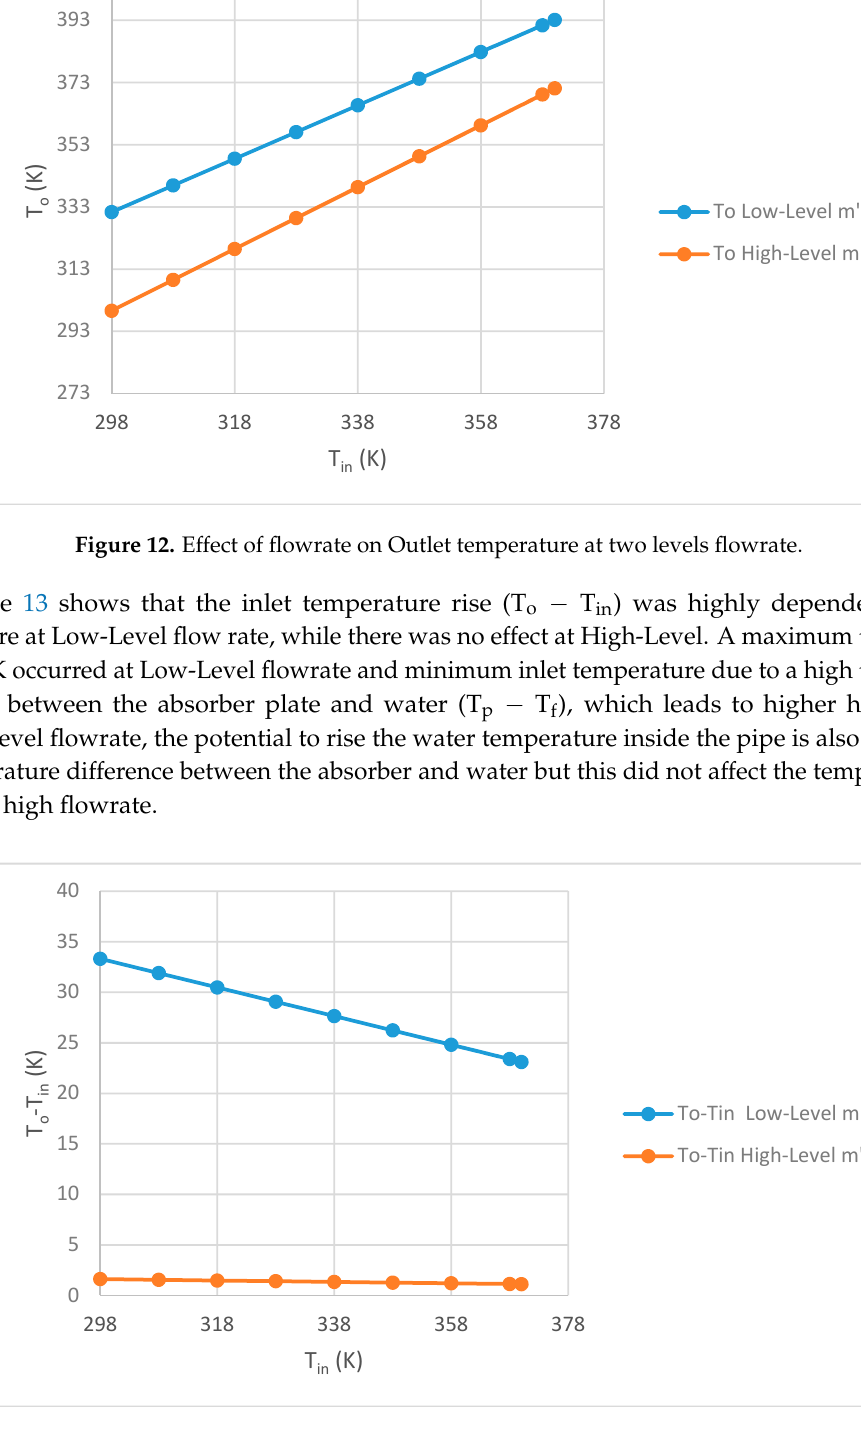
o − T in at two levels